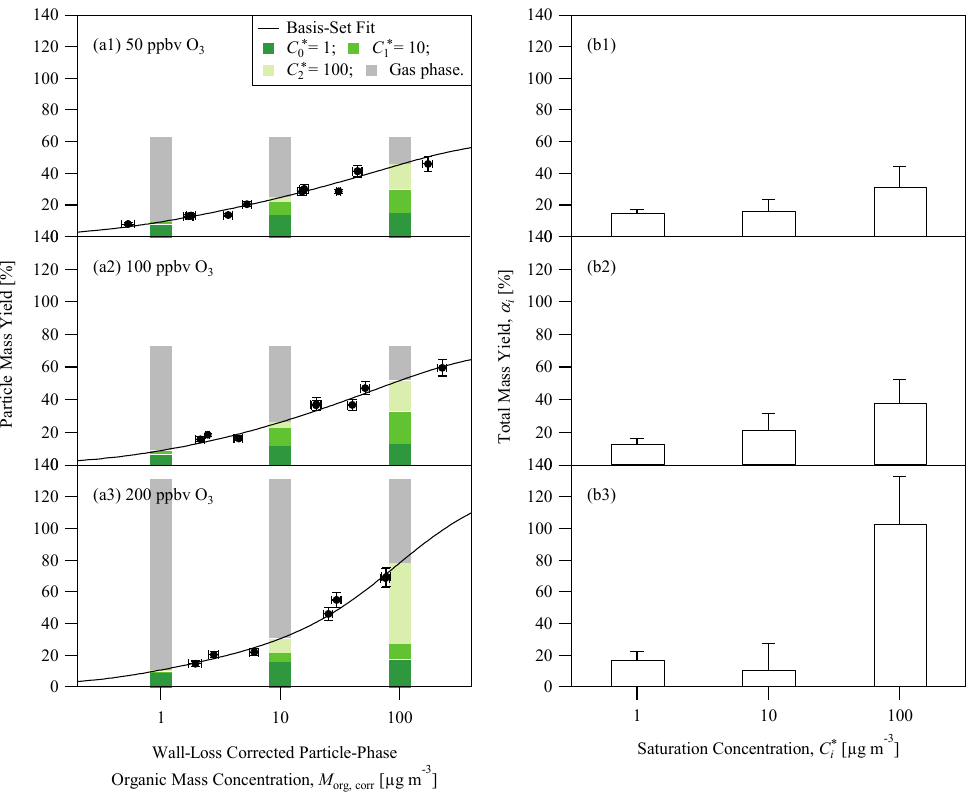
Fig. 5. (a1–a3) Particle mass yield and basis-set parameterization for the dark ozonolysis of β -caryophyllene. (b1–b3) Optimized parameter α i for product classes of C ∗ = { 1, 10, 100 } µgm − 3 . Data are shown for 50, 100, and 200ppbv i